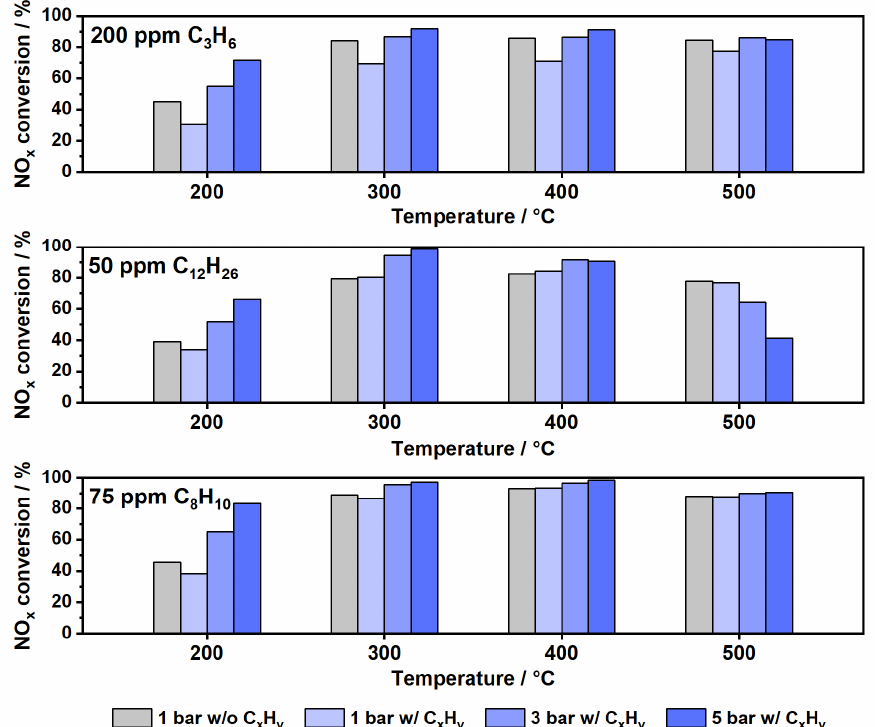
Figure 7. Comparison of NO x conversion at conventional conditions (1 bar in absence of hydrocar- bons) and under pre-turbocharger conditions (1, 3 and 5 bar in presence of hydrocarbons) over a Cu-SSZ-13 in a standard SCR gas mixture.